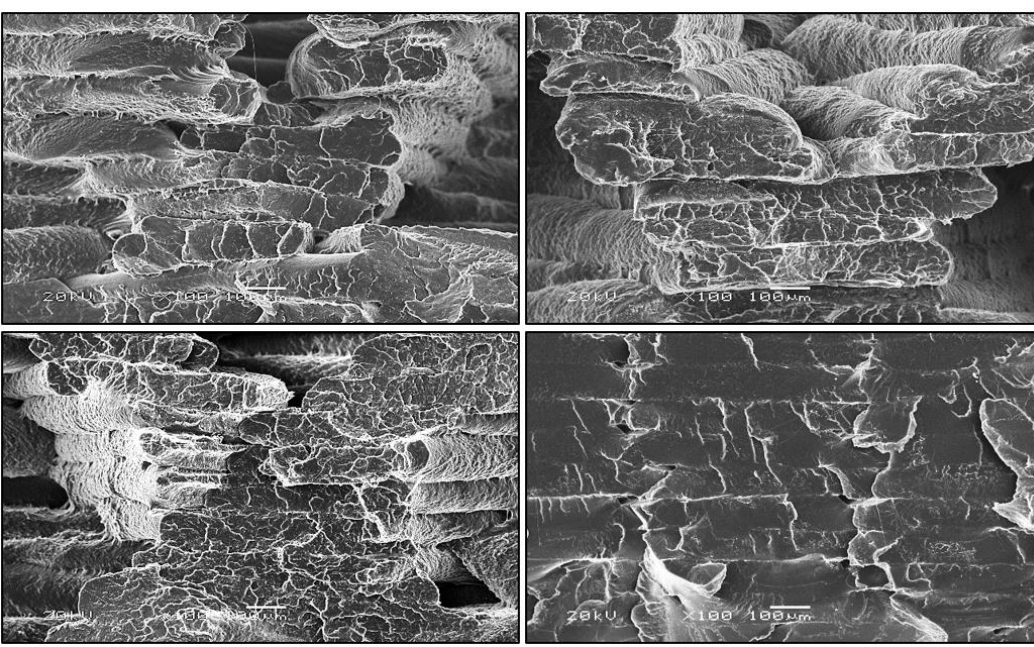
Figure 10. Stretch fracture images for the successive increase in the percent of added infill on SEM images at 100 × magnification.